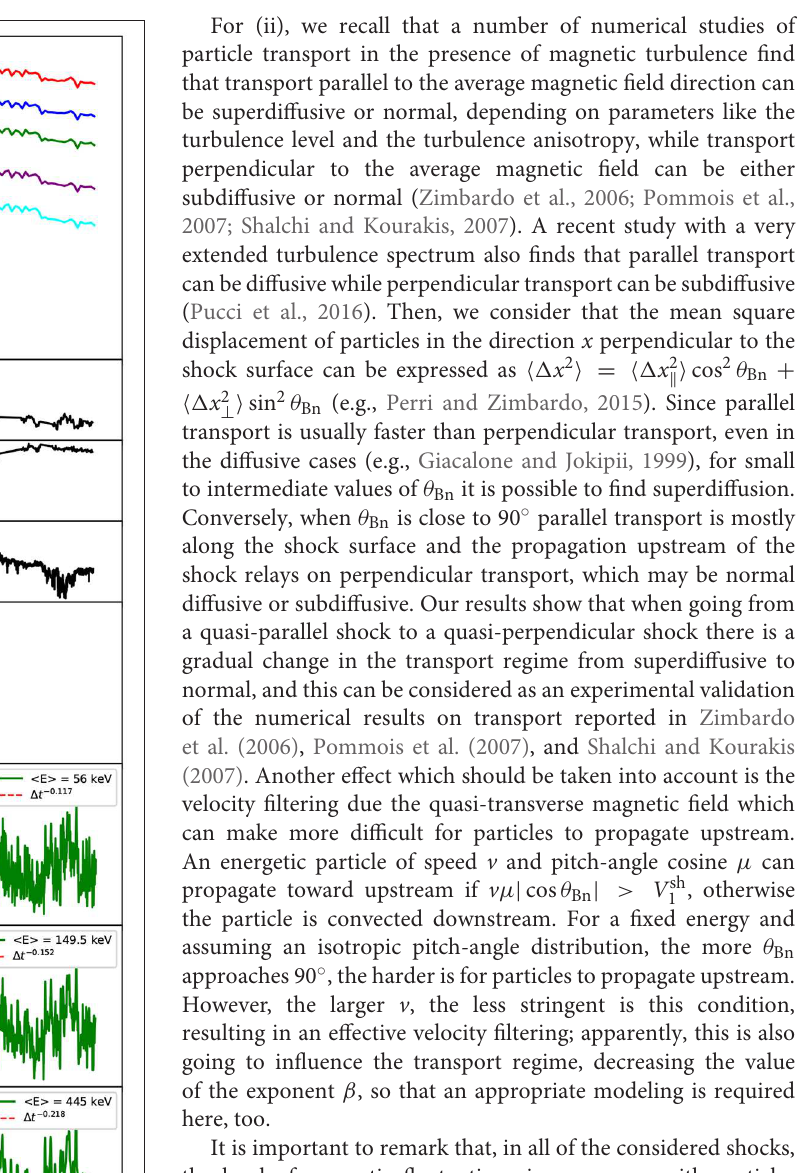
particles (e.g., Giacalone, 2012; Blasi, 2013). In the case of superdiffusive transport, we can see that the exponent of superdiffusion α grows with energy, rather than the anomalous diffusion coefficient. This finding suggests that the pitch-angle scattering due to magnetic fluctuations corresponds to a flatter probability distribution, the larger the particle energy (Perri and Zimbardo, 2012a; Perri et al., 2019), a suggestion which calls for theoretical